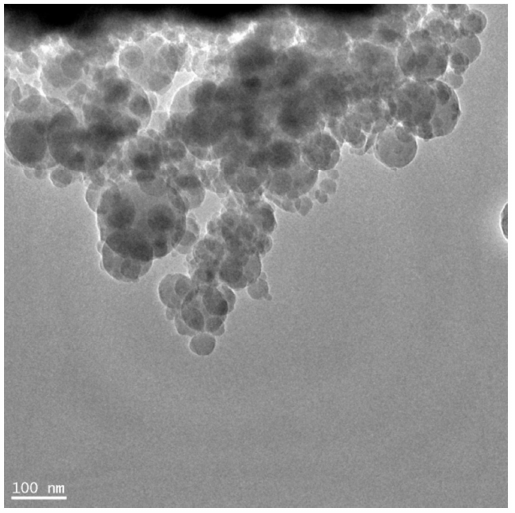
Figure 4. Transmission Electron Microscope (TEM) micrograph of nanosilica (reproduced from [143]).